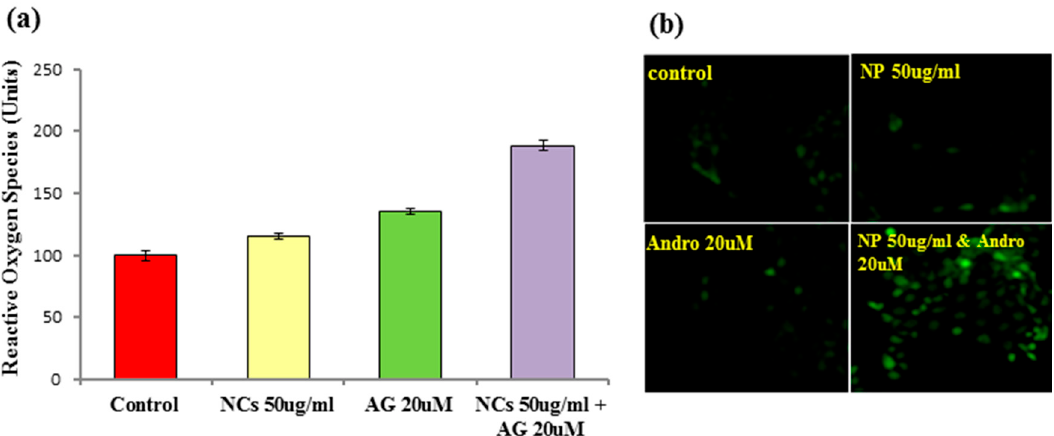
Figure 11. ( a ) Measurement of ROS production of the control, NCs, andrographolide (AG), and AG loaded on Fe 3 O 4 /HAp nanocomposites in A431 cells and ( b ) Fluorescent images of A431 cells treated with different dosages of AG loaded on Fe 3 O 4 /HAp nanocomposites.